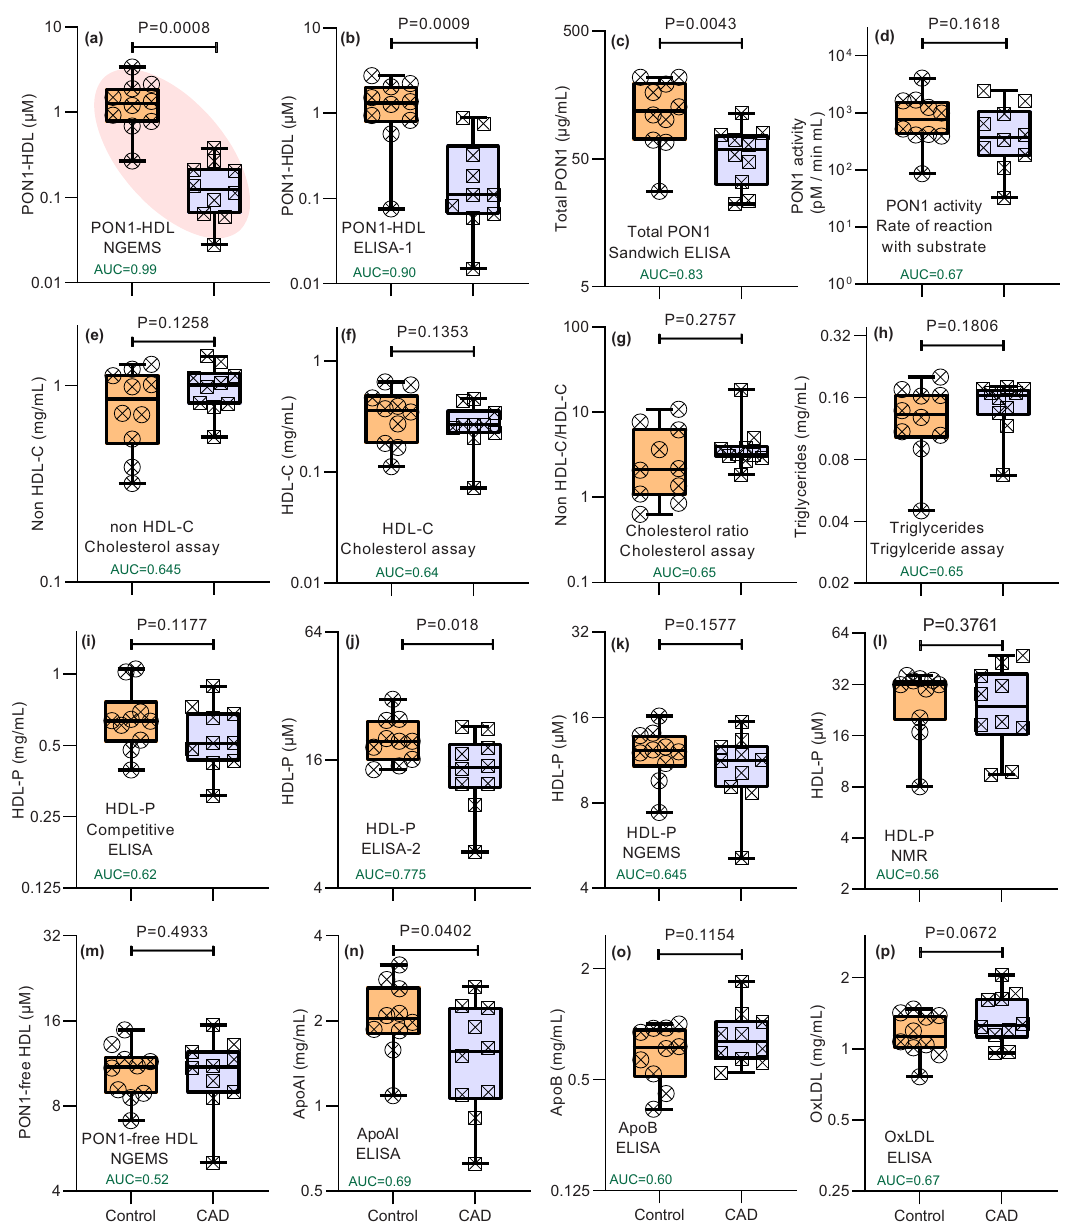
Fig. 7 | Blind study with clinical samples comparing PON1-HDL to other bio- markers from different platforms. a PON1-HDL using NGEMS (AUC=0.99). b PON1-HDL using ELISA-1 (AUC=0.90). c Total PON1 using sandwich ELISA (AUC=0.83). d PON1 activity assay using rate of reaction with substrate (AUC= 0.67). e Non-HDL cholesterol (AUC=0.645), f HDL cholesterol (AUC=0.64) and g cholesterol ratio (AUC = 0.65) from cholesterol assay. h Triglyceride levels from triglyceride assay (AUC=0.65). Total HDL particle concentration HDL-P from i competitiveELISA(AUC=0.62), j ELISA-2(AUC=0.775), k NGEMSassumofPON1- HDL and PON1-free HDL (AUC=0.645) and l 1H-NMR (AUC=0.61). m PON1-free